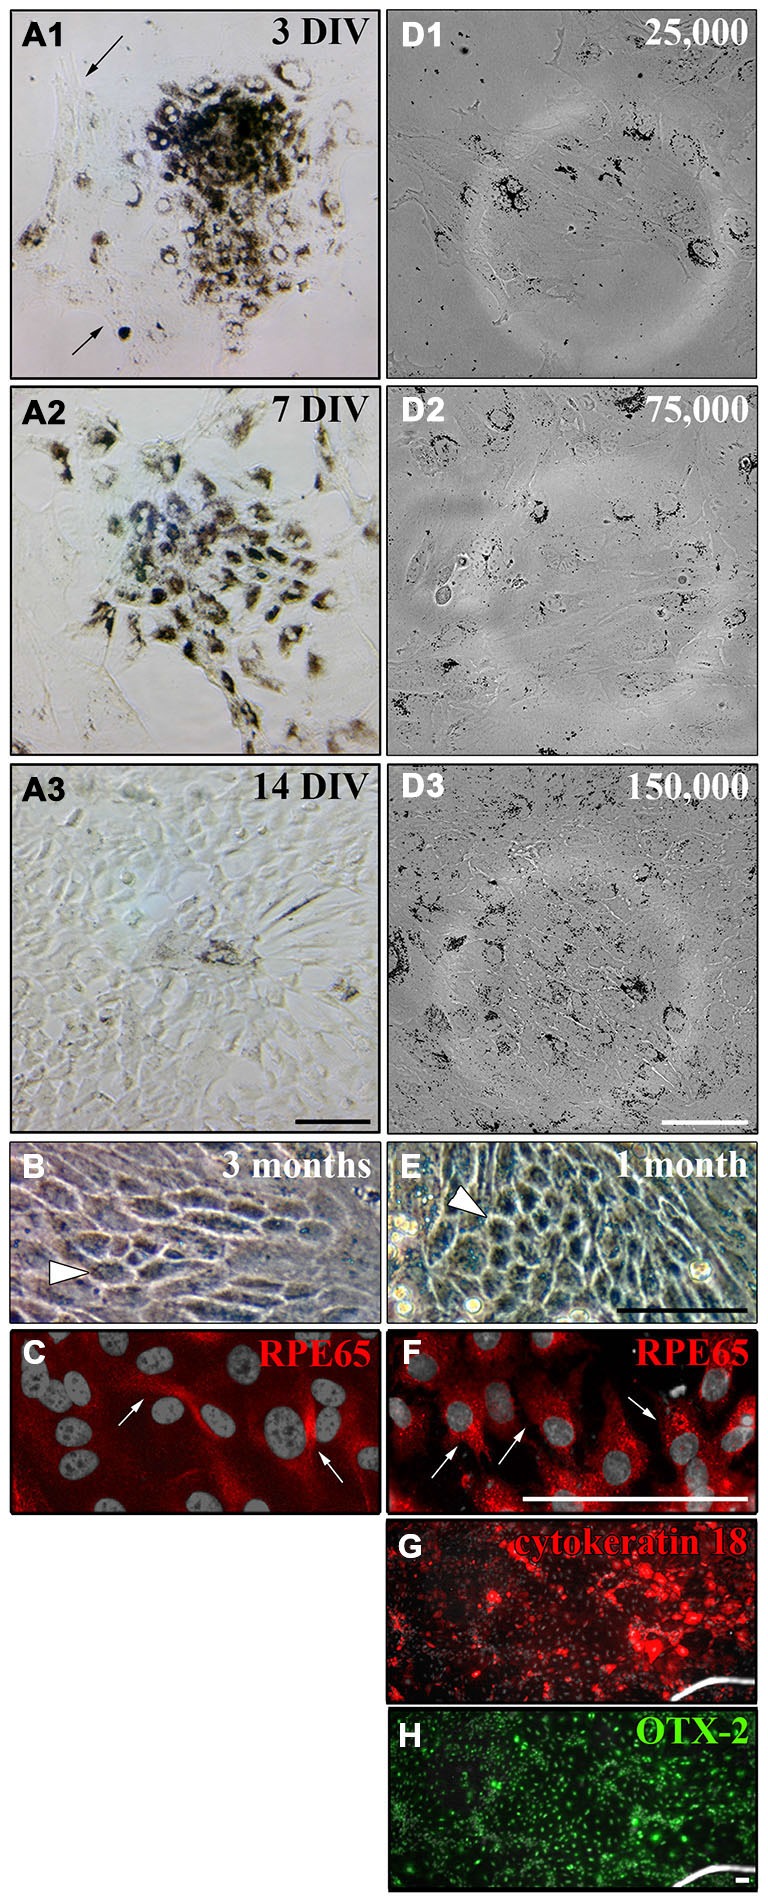
Culture of primary adult RPE cells. (A) Primary RPE cell patches (50–100 cells/patch and ~3500 cells/cm2) were dissected from adult LH rat eyes using incubation of the whole eye in papain for 50 min (20 U/ml) and plated in “Miller” medium on matrigel (1:80 in DMEM). (A1) Three days after dissection, the RPE cells started to proliferate and unpigmented cells appeared around the RPE cell patch (see arrows). (A2) After 7 days in vitro (DIV) the initial RPE cell patch appeared dissolved and the cells covered most of the culture dish. (A3) Although the cells lost their pigments they formed a tight monolayer throughout the culture dish after 2 weeks. (B) Only a few cells either stayed or became pigmented again even after 3 months in culture when ~3500 cells/cm2 were plated (white arrowhead). (C) Only a few pigmented cells in culture expressed RPE65 when ~3500 cells/cm2 were plated (white arrows, see Figure 5). (D) RPE cells were prepared using papain, and 25,000 (~2667 cells/cm2), 75,000 (~8000 cells/cm2) or 150,000 cells (~16,000 cells/cm2) were plated in a well of a 6-well-plate. (D1 and D2) Plating ~2667 or ~8000 cells/cm2 led to a more spread-out morphology of the cells. The tightly packed architecture of the RPE monolayer got destroyed. (D3) The RPE cells stayed pigmented and tightly packed as a monolayer when ~16,000 cells/cm2 were plated. (E) Plating more cells initially (~16,000 cells/cm2) resulted in a tighter and more pigmented monolayer after 1 month in culture (white arrowhead). (F) Almost all cells expressed RPE65 when more cells were plated initially (white arrows). (G and H) All cells in culture expressed cytokeratin 18 and OTX-2. Scale bar = 100 μm.